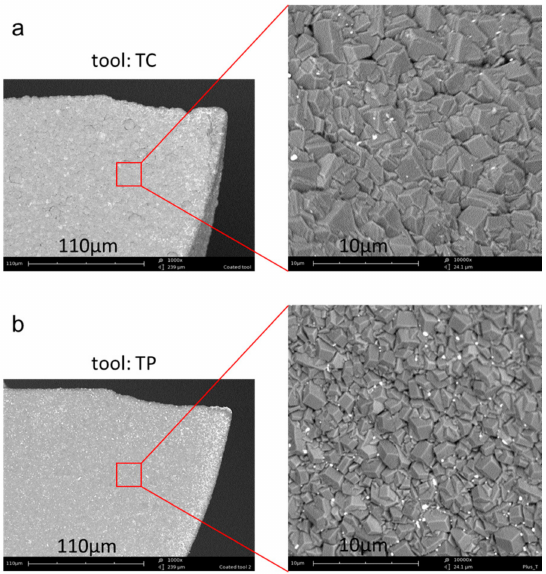
Figure 2. Surface morphology of the two kinds of diamond coating: ( a ) TC—conventional diamond coating; ( b ) TP—nanocrystalline diamond